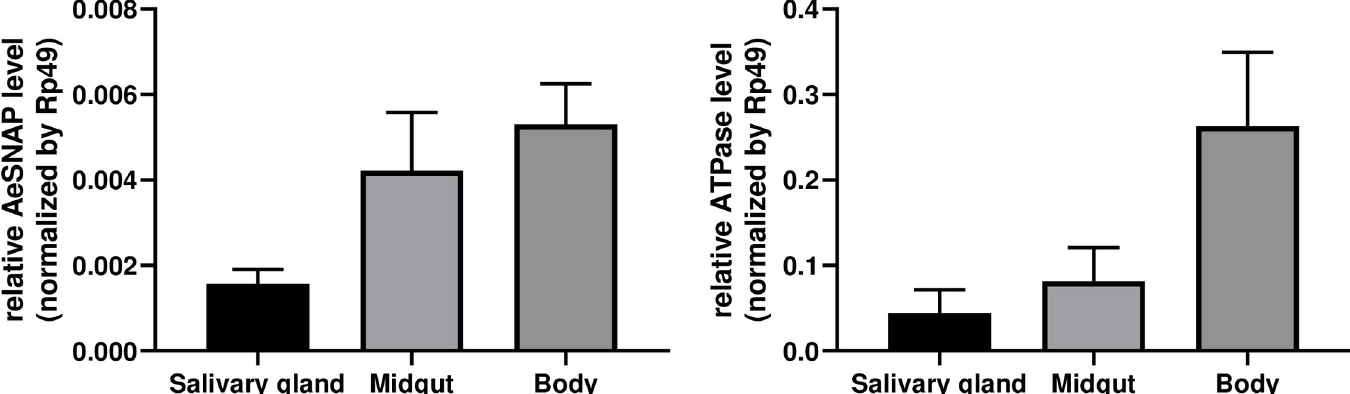
Fig 4. Differential gene expression of AeSNAP and ATPase. AeSNAP (left) and ATPase (right) relative expression was detected in salivary glands and midgut, and relative expression was also evaluated in the whole mosquito body in. AeSNAP and ATPase RNA levels were analyzed by qRT-PCR and normalized to the levels of Rp49.